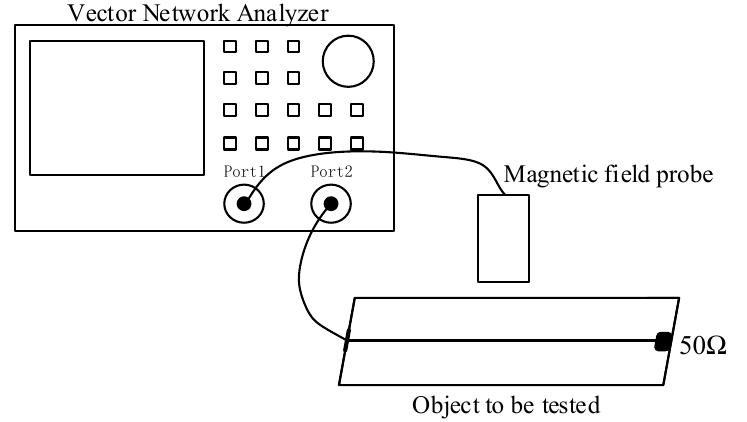
Figure 16. Schematic diagram of S 12 and S 11 parameters measured in